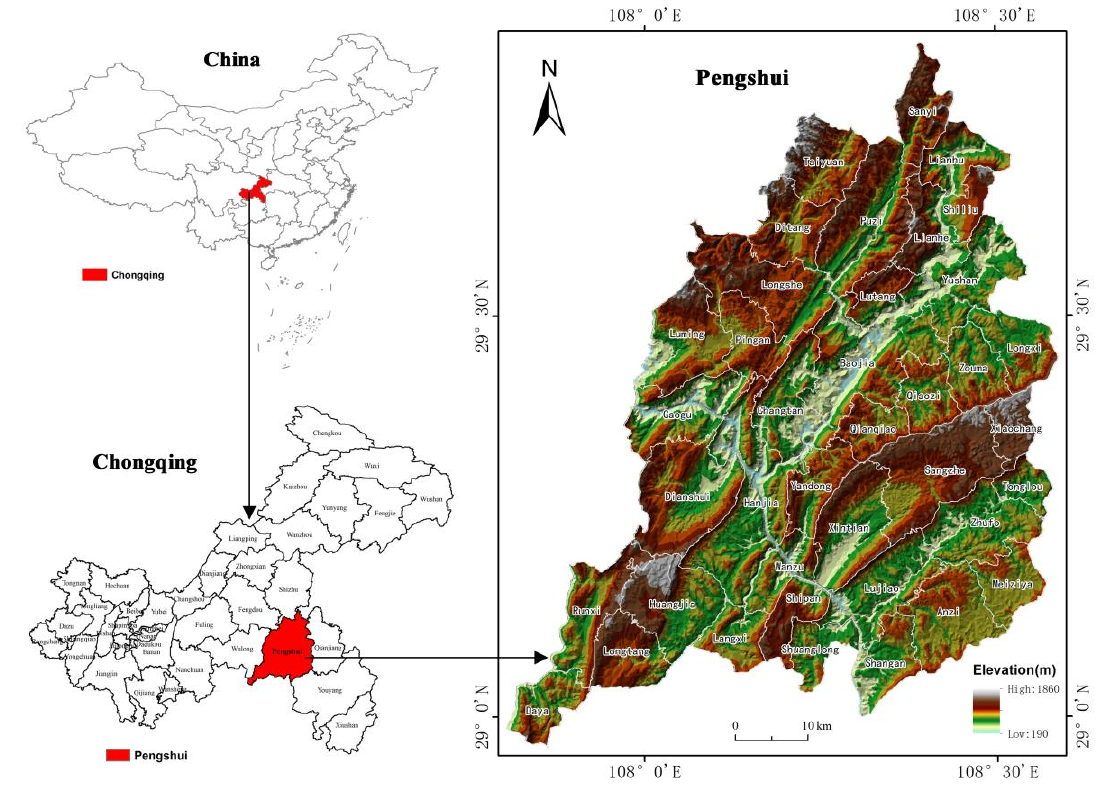
Figure 1. Location of the study area.